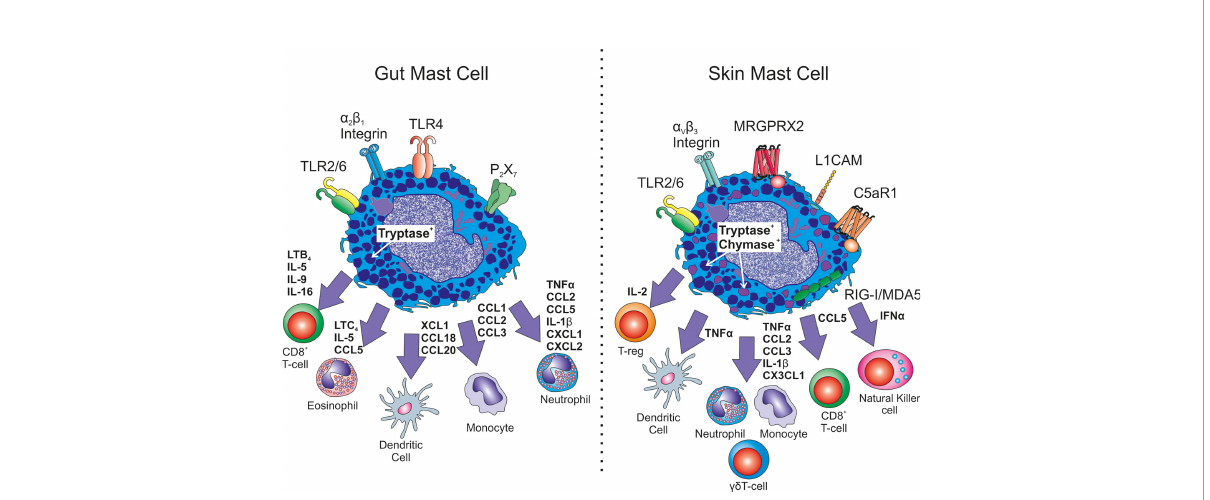
FIGURE 1 Heterogeneity in immune cell recrutiment. Exemplary differences between mucosal gut mast cells and connective tissue skin mast cells are shown. Differences in receptor expression include TLR4, P2X7, L1CAM, C5aR1, MRGPRX2 as well as integrin expression. Different mast cell mediators have been shown to be released with altered down stream consequences for immune cell recruitment in infection or in fl